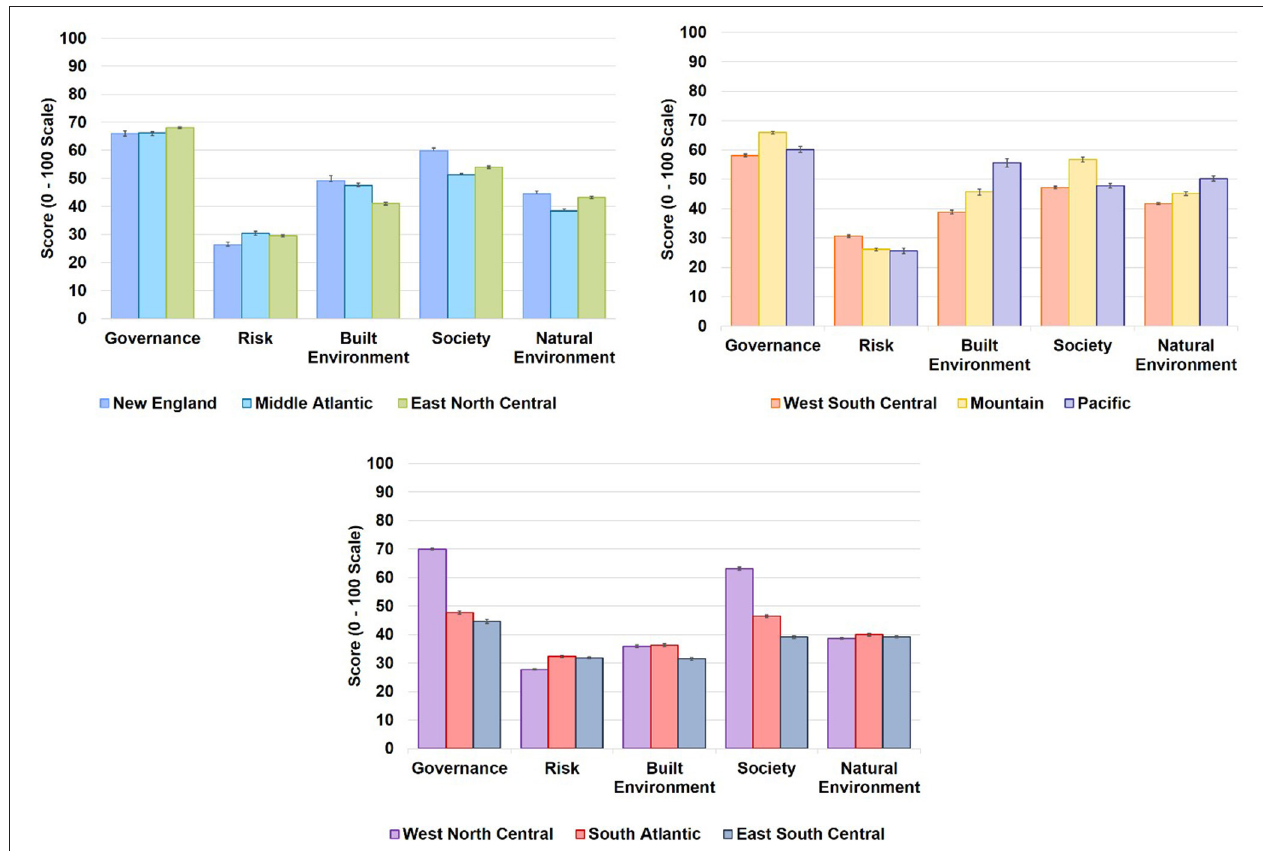
FIGURE 3 | Domain scores by U.S. Region (vertical bars represent